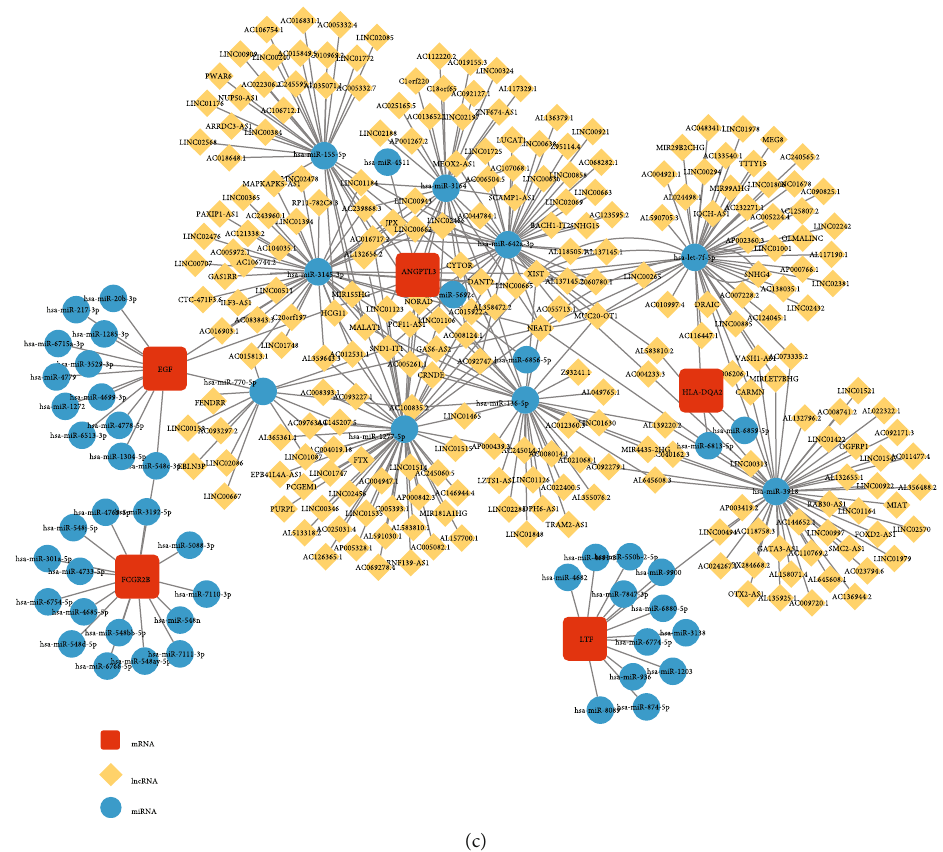
Figure 6: IPA of the IF/TA-related DEGs and construction of ceRNA network for diagnostic genes. (a) Canonical pathway analysis. Blue indicates that the corresponding pathway is inhibited and orange indicates activation. (b) Disease and functional pathway analysis. (c) The ceRNA network with 310 nodes and 392 edges were reconstructed to further reveal the possible role network of diagnostic genes. (red square, mRNA; yellow diamond, lncRNA; and blue circles,